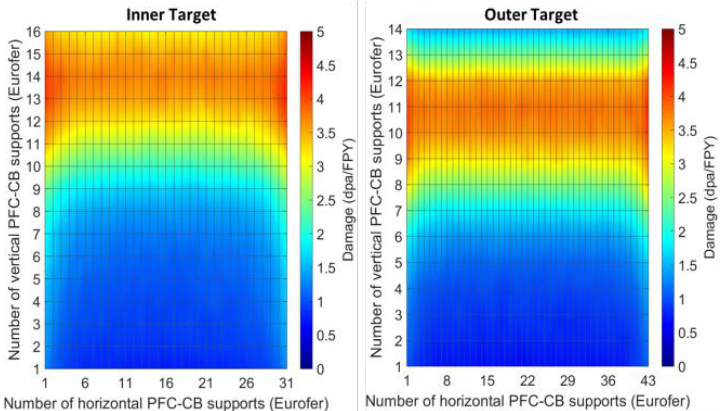
Figure 22. Nuclear damage (dpa/FPY) distribution on PFC-CB supports (Eurofer) of the inner ( left ) and outer ( right ) target, with HCPB blanket.